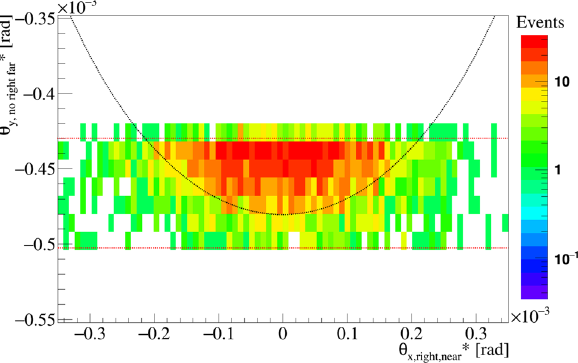
Fig. 4 GeometricalacceptancecutforDiagonal1inthe (θ ∗ x ,θ ∗ y ) plane. The red lines show the acceptance cuts. In order to optimize the accep- tance the right far RP was not used, denoted in θ ∗ Sect.